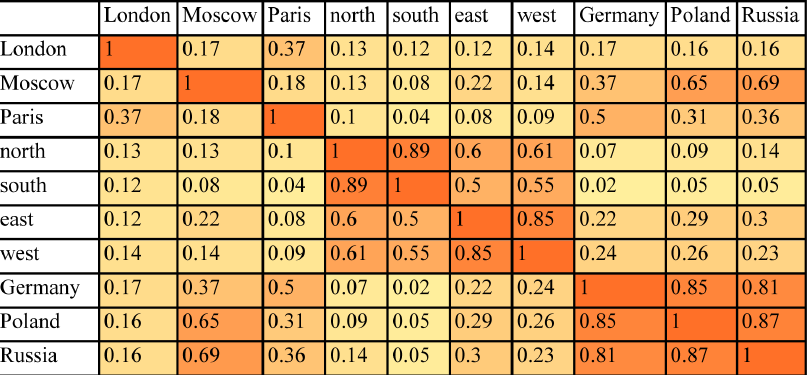
Figure 6 for the example of London . (Data for the other words can be found in Figure S1 a–j.) The Spearman rank correlation for the brain data and the WordNet-derived data in Figure 6 is 0.99, with one-sided significance of 1.84E-10. The Spearman rank correla- tion for the brain data and the LSA-derived data in Figure 6 is 0.8758 with one-sided significance of 8.9494e-004. The Spearman rank correlation, as an indication of the strength of the relationship between two partial orders, is a statistic of interest. But what is of primary interest based on the approach described in section 2.4